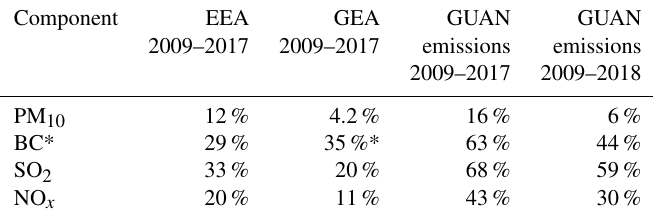
Table 3. Percental decreases in anthropogenic emissions of PM 10 , BC, SO 2 , and NO x relative to 2009 as reported by the European En- vironment Agency (EEA, https://www.eea.europa.eu/data-and-maps/dashboards/air-pollutant-emissions-data-viewer-2), the German Envi- ronment Agency (GEA), and calculated in the present study. The EEA and GEA only report data until